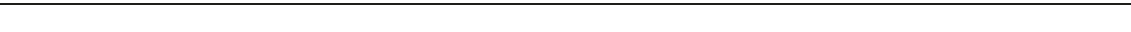
Fig. 2 hlx1 regulates the transcription of metabolic genes. a Heatmap of z-transformed normalized gene expression values from RNA-Seq performed on sorted endothelial/hematopoietic ( fl i:kaede + ) cells from fl i :h HLX OE embryos or endothelial cells ( kdrl:GFP + ) from hlx1 MO at 48hpf after unsupervised hierarchical clustering with Euclidean distance metric (see also Supplementary Data 1). b IPA analysis of deregulated genes in the RNA-Seq data from fl i : h HLX OE or hlx1MO embryos at 48hpf (NBT, P ≤ 0.05 and ≥ 2 fold change) (also see Supplementary Data 1). c Mean density plots of read distribution of lost and gained ATAC-Seq peaks between control and hlx1 MO (see also Supplementary Data 2). d Digital genomic footprinting analysis showing average normalized Tn5 insertion pro fi les around footprinted motifs in merged ATAC peaks as indicated for control and hlx1MO (co-occurrence enrichment computation, z = 3.583 and z = 13.241, respectively). Insertions on the forward and reverse strands are indicated in red and blue, respectively. The numbers of motifs are indicated at the bottom of each panel. e Representative gene tracks from ATAC-Seq data of ETC and ppardb genes. f Heatmap of ETC gene expression in hlx1MO or fl i :h HLX OE compared to control from the RNA-Seq analysis. All represented genes show differential chromatin accessibility in ATAC-Seq. g – i qPCR analysis of selected ppar genes in g endothelial cells from hlx1 MO (data representative of two independant experiments, mean + s.d.) or ( h ) whole fl i :h HLX OE embryos at 48hpf ( n = 3, mean + s.d., Student ’ s t -test, * P <0.05) or ( i ) whole Runx :h HLX OE embryos at 5dpf ( n = 2, mean +